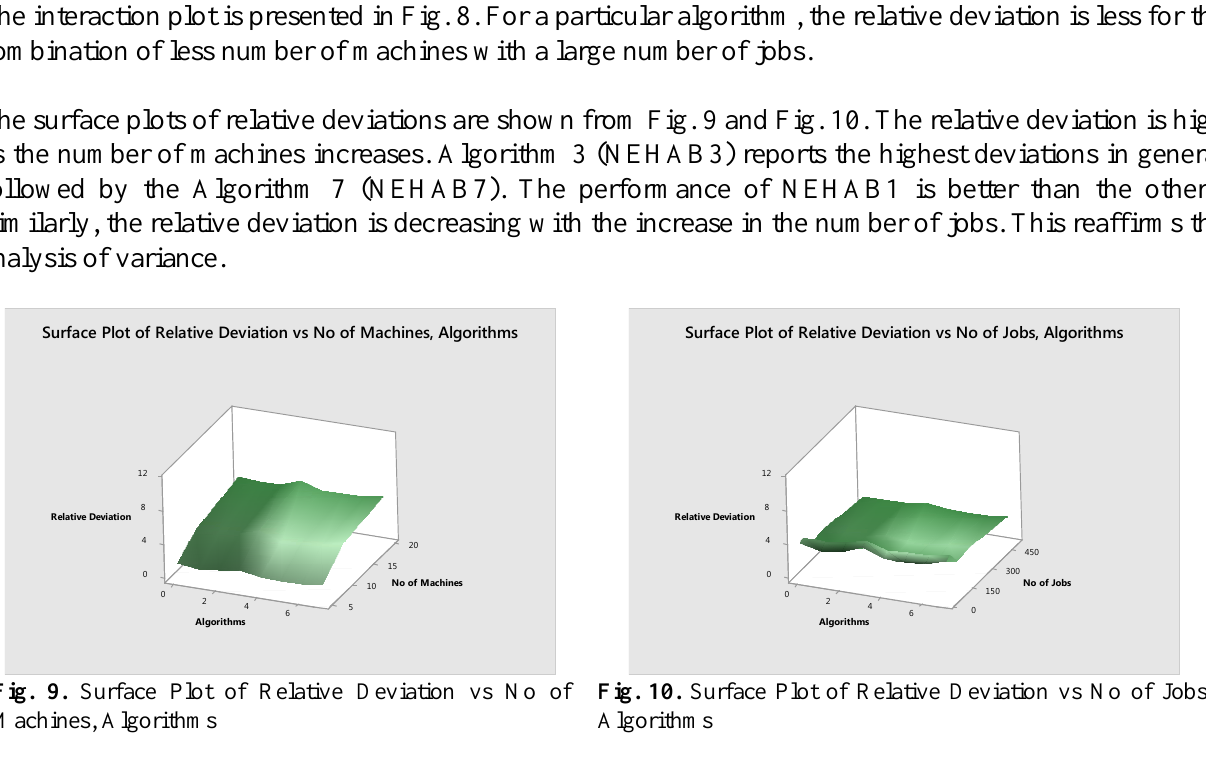
Fig. 10. Surface Plot of Relative Deviation vs No of Jobs,